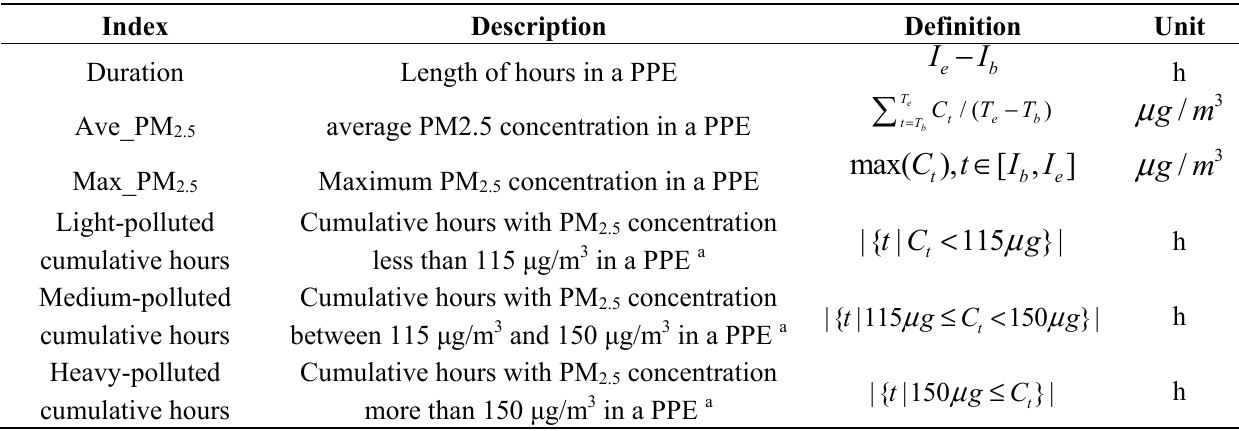
Table 1. Definitions of six indices of PM 2.5 Pollution